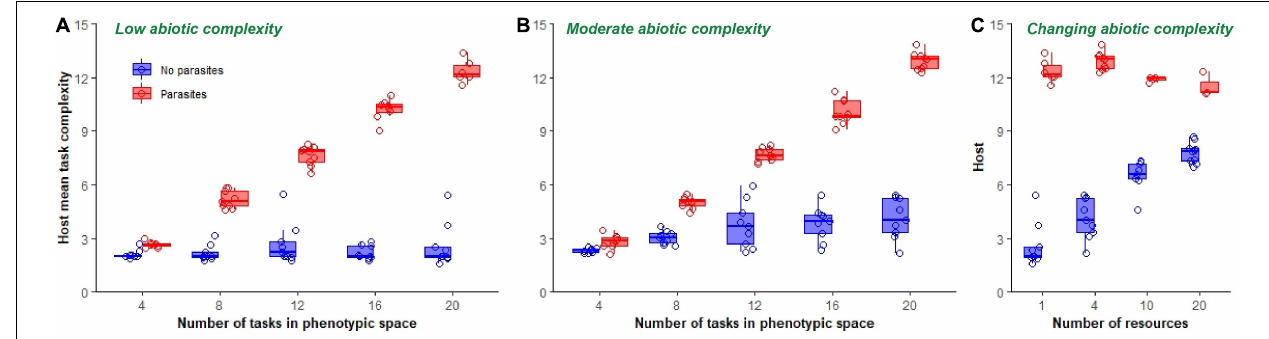
FIGURE 6 | Final mean task complexity of hosts. Boxplots show final mean task complexity of host populations at the end of 300,000 updates in populations evolving in a single resource environment (A) , a four-resource environment (B) , and in environments of increasing ecological complexity (C) . Data from non-coevolving populations is shown in blue, while data from coevolving populations is shown in red. Mean task complexity was calculated by summing the frequencies of each task, multiplying by its rank identifier (which here served as an approximate measure of complexity) and dividing by the total number of tasks performed in each replicate population. Only data from those host populations in which parasites did not go extinct are shown.